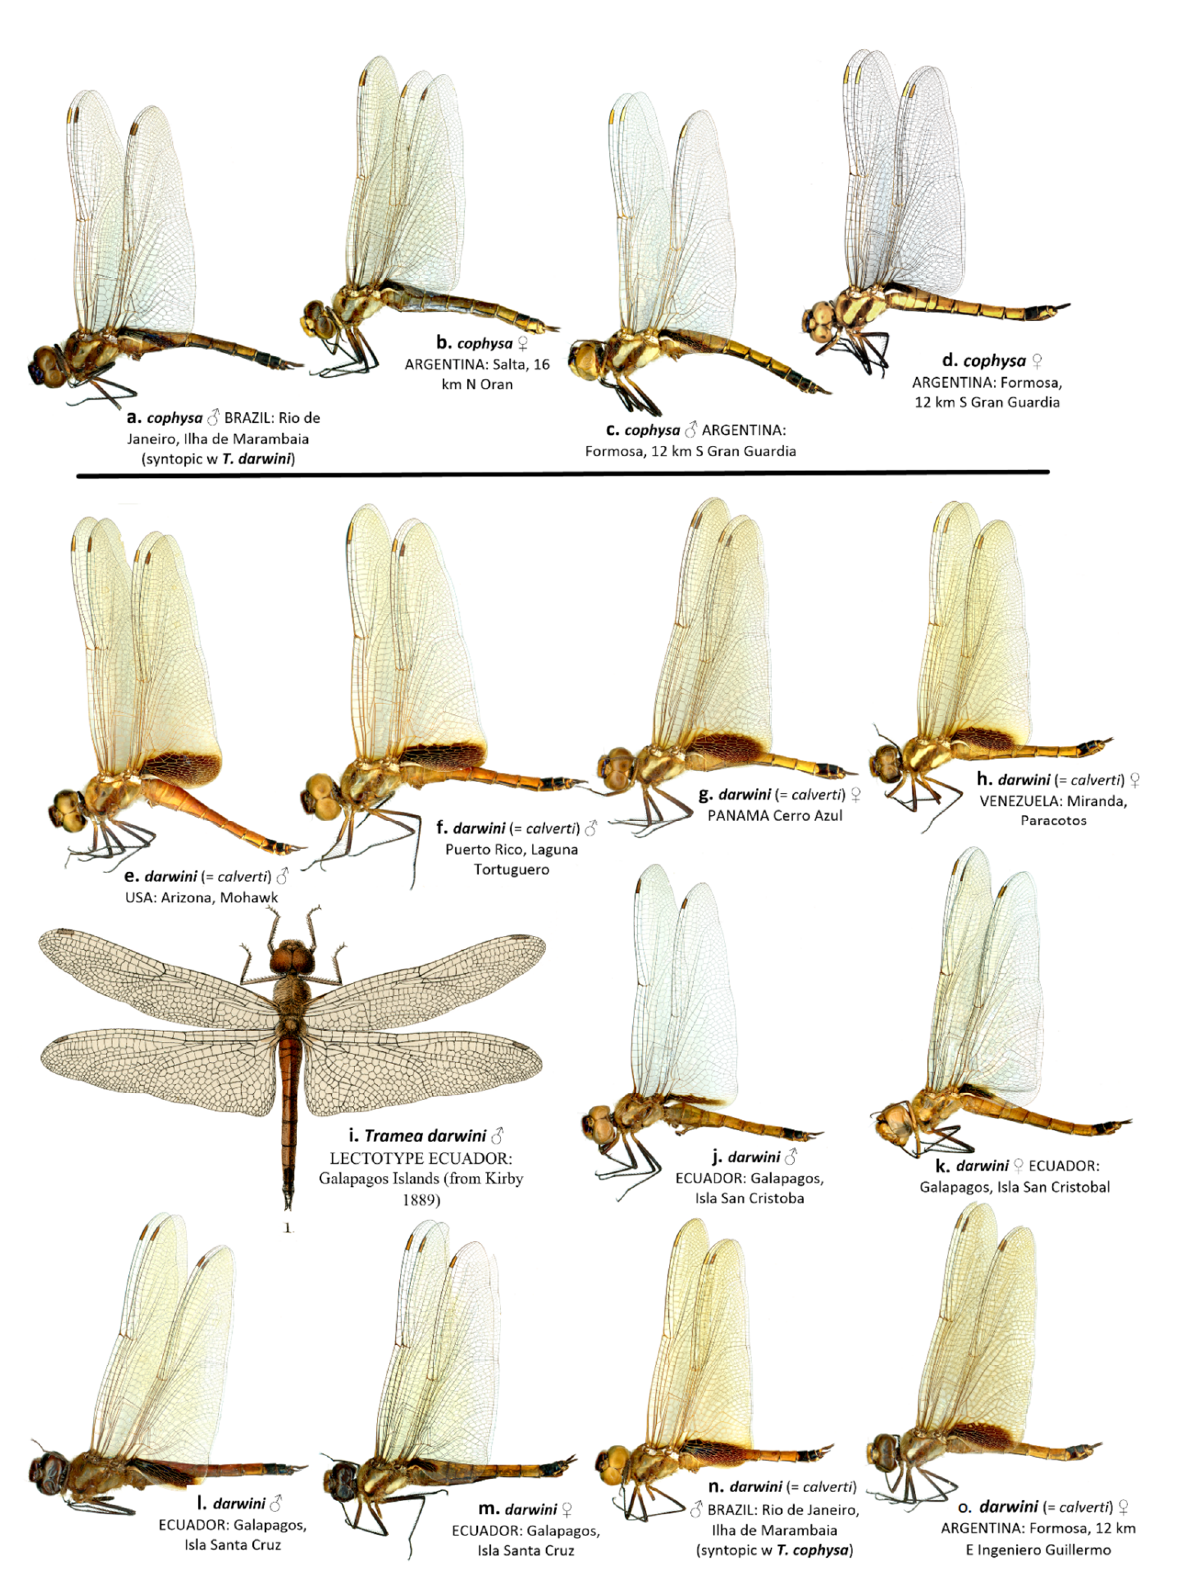
Figure 4. Lateral view of habitus of T. cophysa ( a – d ) and T. darwini (senior synonym of T. calverti , stat. rev.) ( e – o ). Dorsal view of the lectotype of T. darwini Kirby 1889 is also included ( i ).